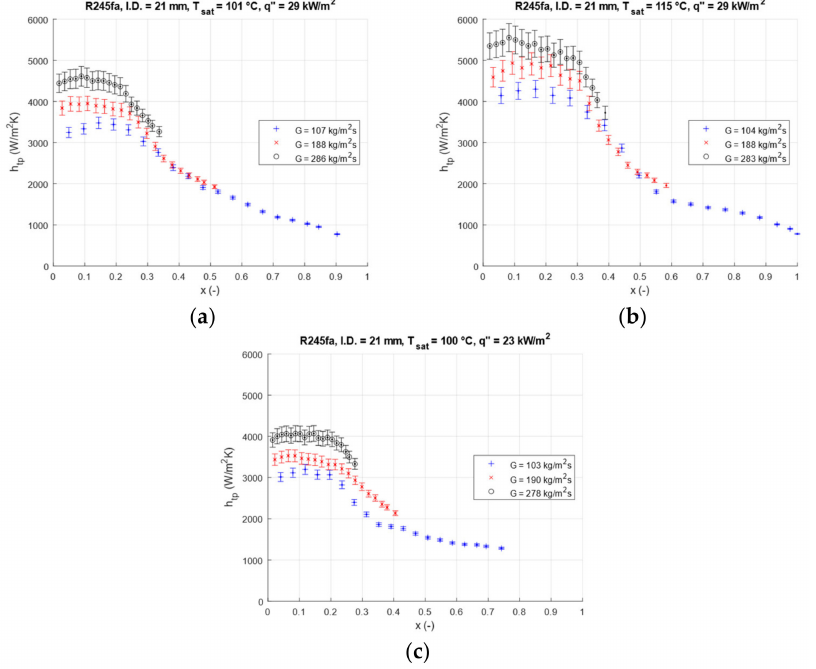
Figure 7. Local experimental two-phase heat transfer coefficients at changing mass flux, at ( a ) fixed low-T . q case ( Re L = 13,618–36,399), ( b ) fixed high-T and high- and high- . q case ( Re L = low-T and low-